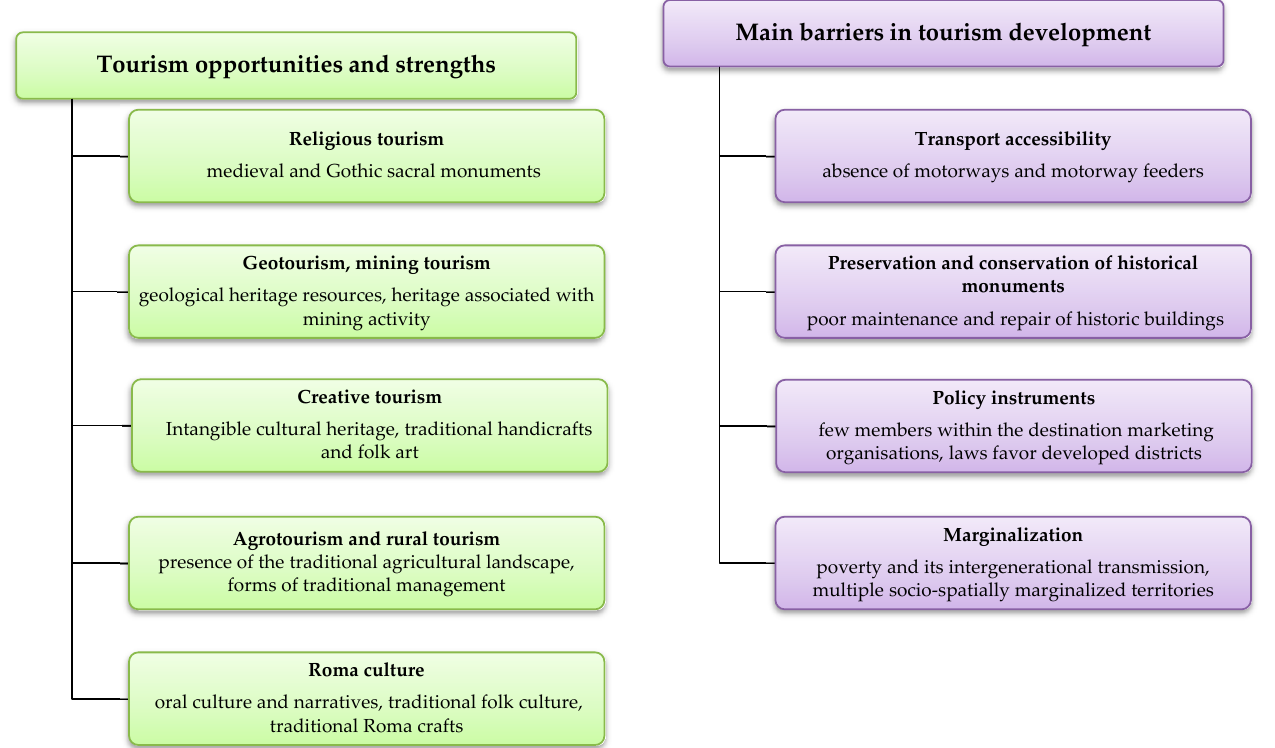
Figure 2. Methodological approach to the identification of opportunities and strengths, and barriers in tourism development.